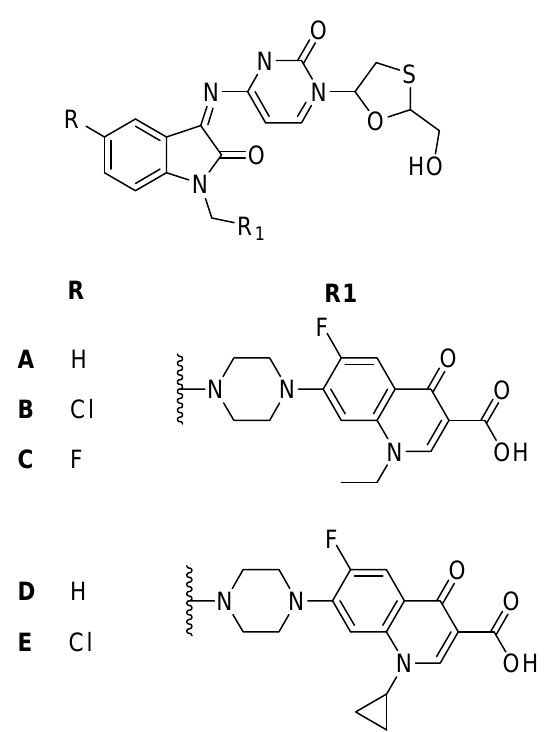
Figure 39. Prodrugs of